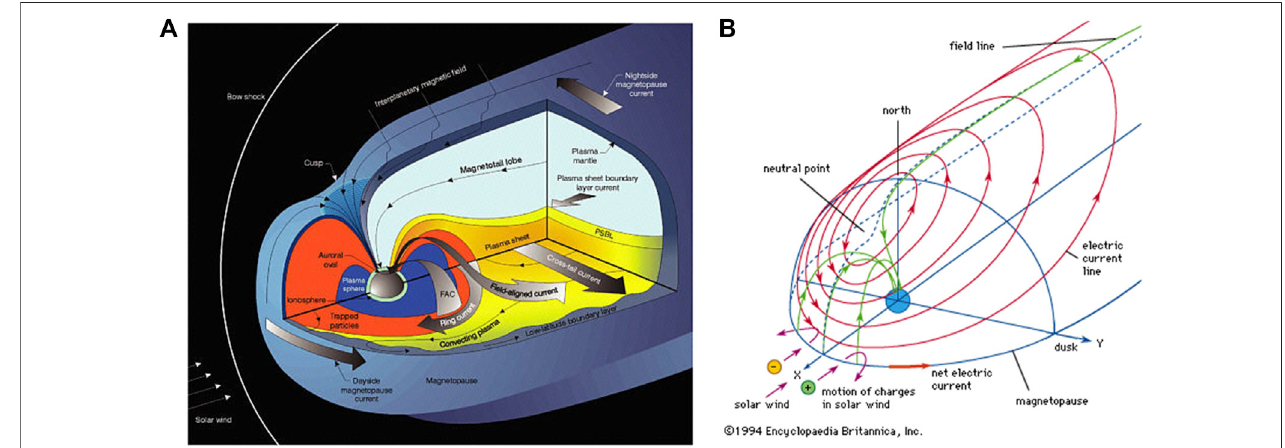
FIGURE 11 | (A) Schematic diagram of the Earth ’ s magnetosphere and current structure with the trapped particles of the inner magnetosphere (representing the radiation belts) shown as the orange region, the plasmasphere shown in blue, while the lobe regions — extending into the magnetotail — are shown in light blue. The currents are represented by the various grey arrows, with the Chapman-Ferraro current (or the magnetopause current) going from dawn to dusk around the magnetopause and the ring current fl owing in the opposite dusk to dawn direction further into the inner magnetosphere. The plasma sheet or the magnetotail neutral sheet is then depicted in yellow. Also note the presence of fi eld-aligned currents (FACs) linking the various current systems together to form a coherent system that connects with the Earth ’ s ionosphere. Image Credit: Pollock et al. (2003). These images were distributed under the